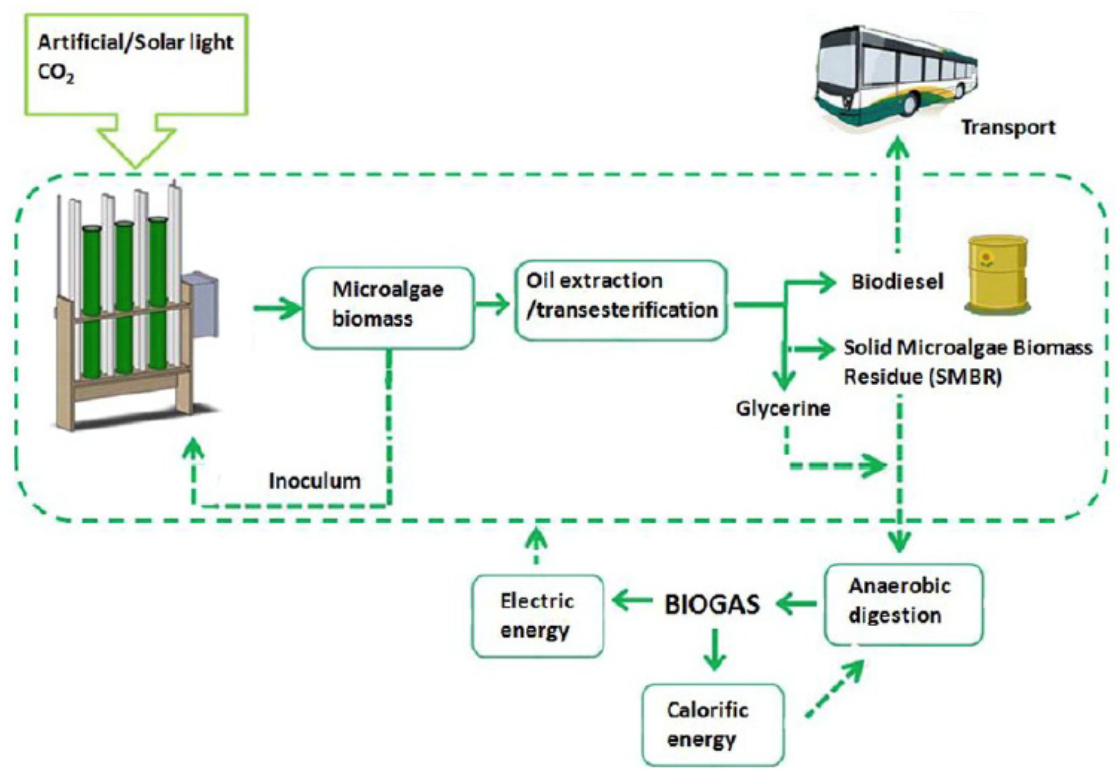
Figure 3. Producing biofuels or other by-products with Symbiodinaceae . Schematic process of biofuel (biodiesel and biogas) production from microalgae biomass; the bioreactors will permanently generate energetic products (or other substances) that can be used in local economies; when a bleaching event occurs, the local government, with the help of the local population, may use part of the production to restore the before-bleaching conditions of the scleractinians (from [49]).